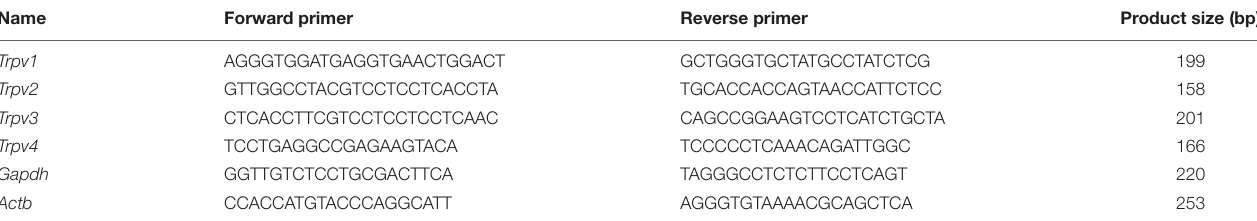
TABLE 1 | Primer sequences used for PCR and semiquantitative real-time PCR